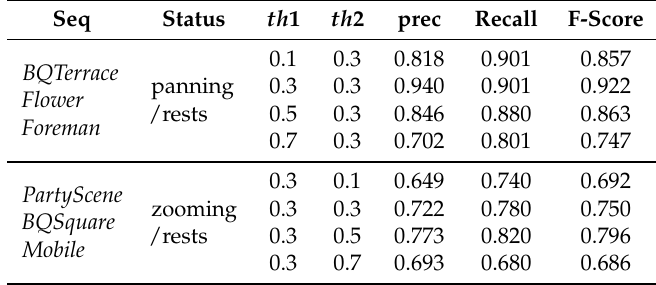
Table 2. Performance of camera status decision with different settings of